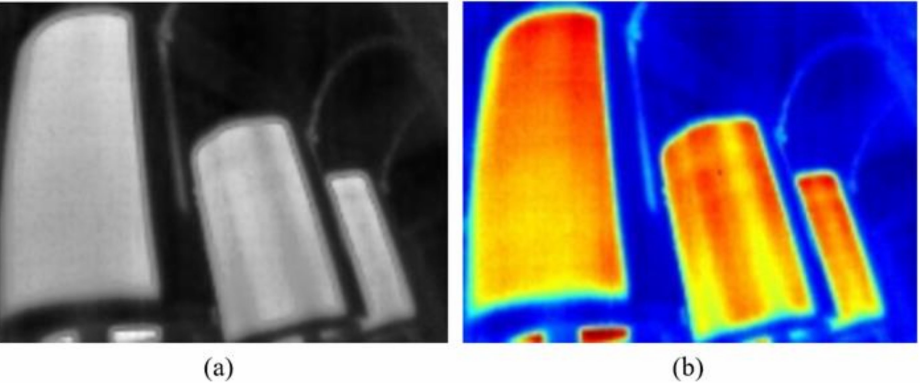
Figure 3. ( a ) The grayscale thermal image. ( b ) Convert image to RGB color within a JET color